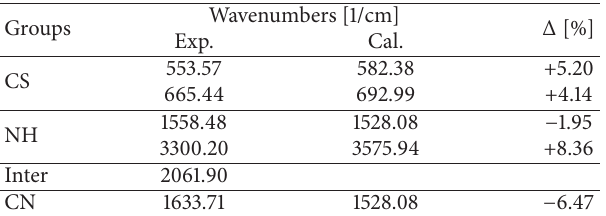
Table 3: The comparison of experimental (in Figure 5) and theo- retical (in Figure 3(b)) frequencies of PSTM-3T after treatment by nitric acid (pH = 5) solution. The percentage of relative deviation of model in different frequencies is shown in parenthesis.